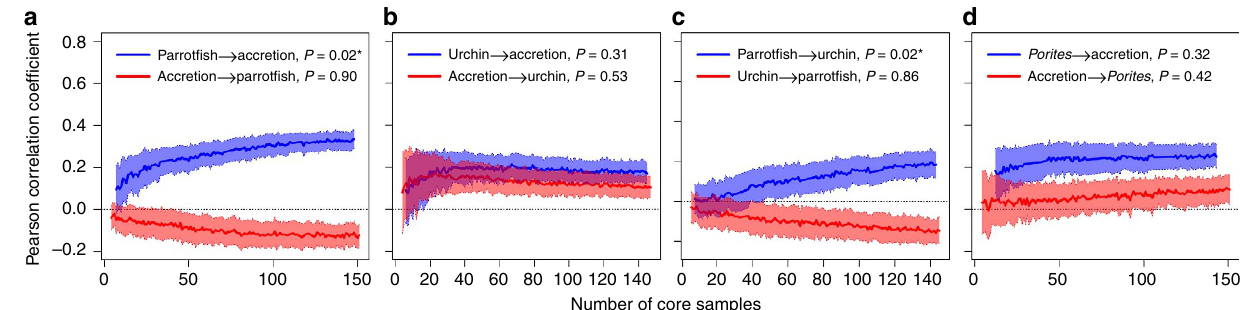
Figure 4 | Analysis of causality between reef accretion and abundance of herbivores or dominant coral. ( a ) Parrotfish relative abundance and reef accretion rate. ( b ) Urchin abundance and reef accretion rate. ( c ) Parrotfish relative abundance and urchin abundance. ( d ) Branching Porites coral relative abundance and reef accretion rate. Lines and shaded regions show mean ± s.d. from 100 bootstrapped iterations. Significant causal forcing (*) determined from bootstrap test with 100 iterations, and indicated when the Pearson correlation coefficient is significantly greater than zero for larger sample sizes (number of core samples, including all spatial replicates in the composite time series) and when correlation coefficient increases significantly